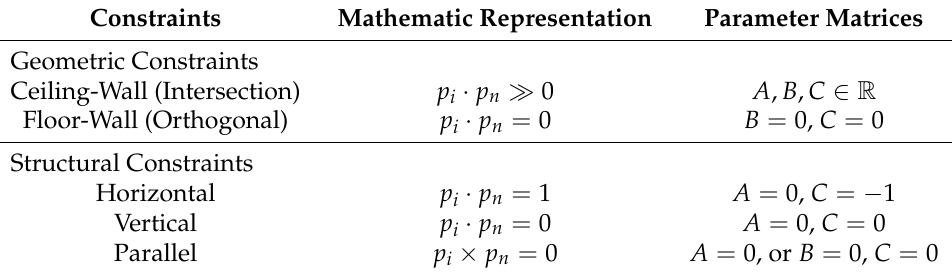
Table 1. Structural constraints and